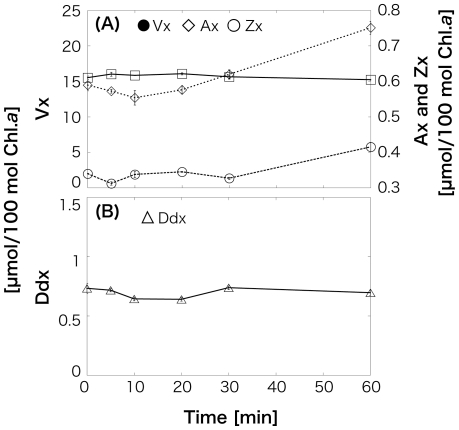
Time course of xanthophyll cycle pigment changes in Ochromonas itoi in high-light (HL) after 6-h HL illumination, followed by 1-h low-light (LL) illumination.Pigments are normalized to chlorophyll a (Chl.a). Values are means of three independent records, and error bars are standard deviations. A, Deepoxidation of violaxanthin (Vx) from antheraxanthin (Ax) to zeaxanthin (Zx); B, deepoxidation of diadinoxanthin (Ddx) to diatoxanthin (Dtx).